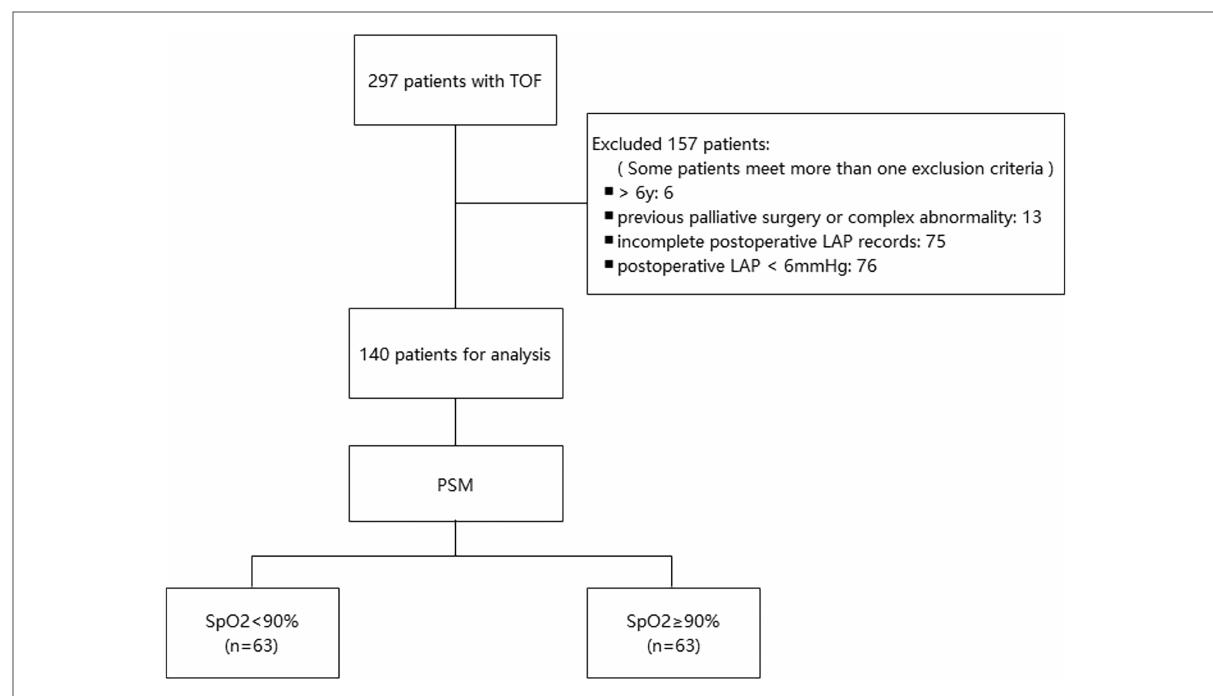
FIGURE 1 Flowchart of the study. LAP, left atrial pressure; PSM, propensity score matching; SpO 2 , oxygen saturation; TOF, tetralogy of